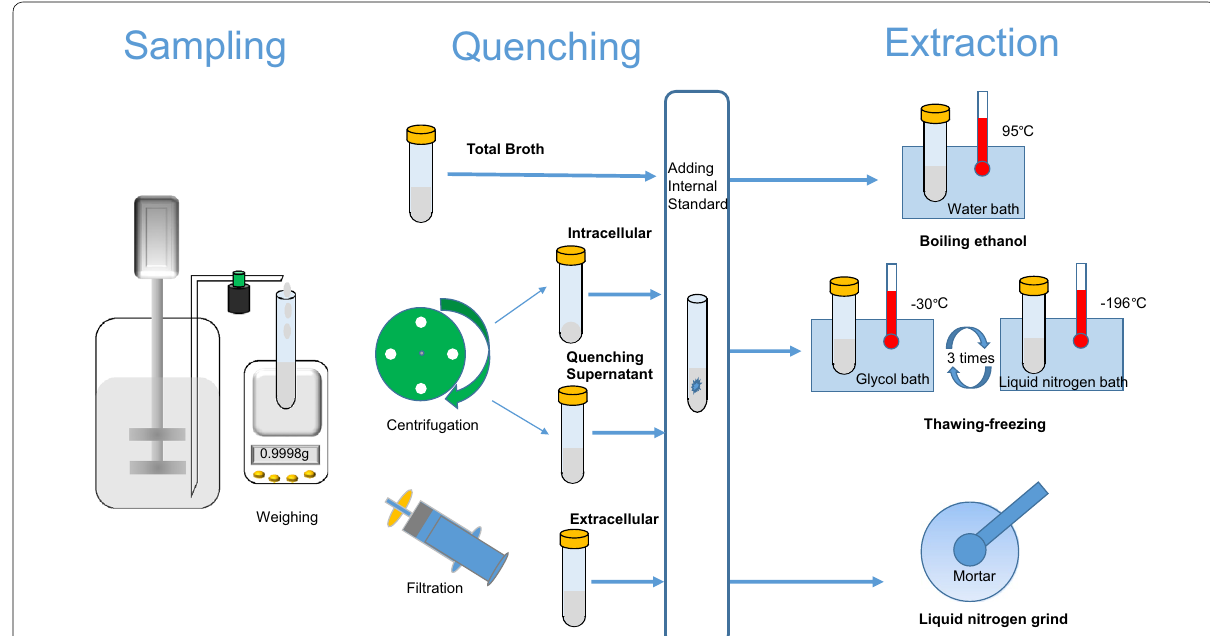
Fig. 1 Schematic representation of rapid sampling, quenching, and extraction procedures for Streptomyces . The three extraction procedures were (1) boiling ethanol: 75% (v/v) ethanol in 95 °C 4 min; (2) thawing–freezing in liquid nitrogen in 50% (v/v)